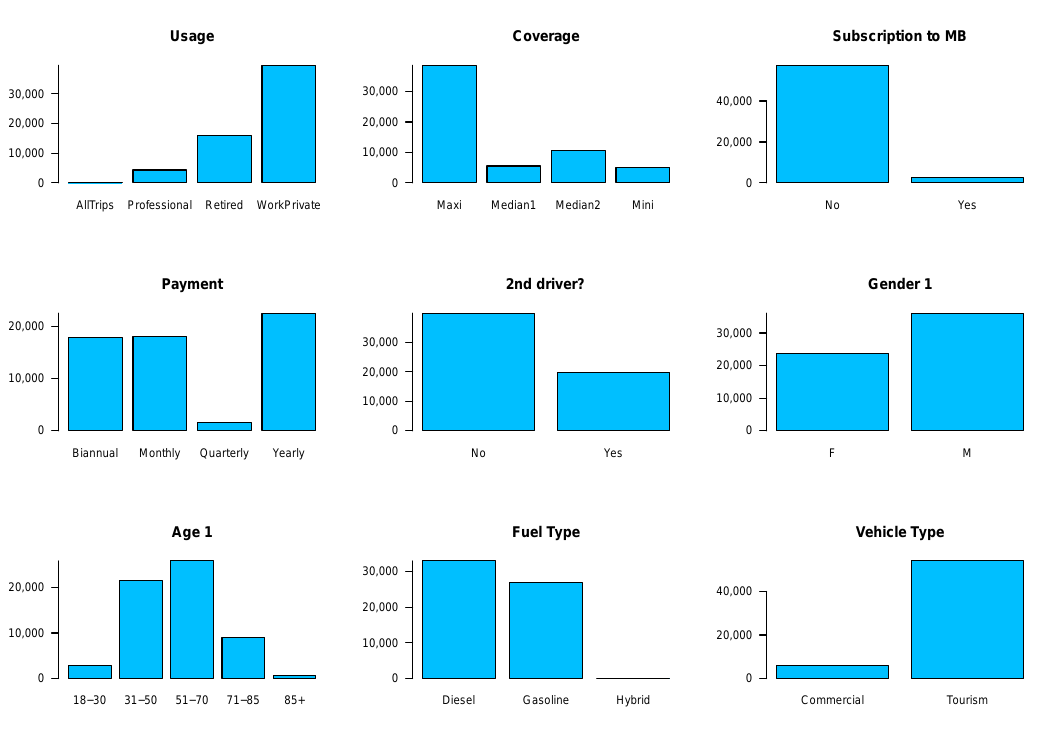
Figure 2. Distribution of policies according to categorical